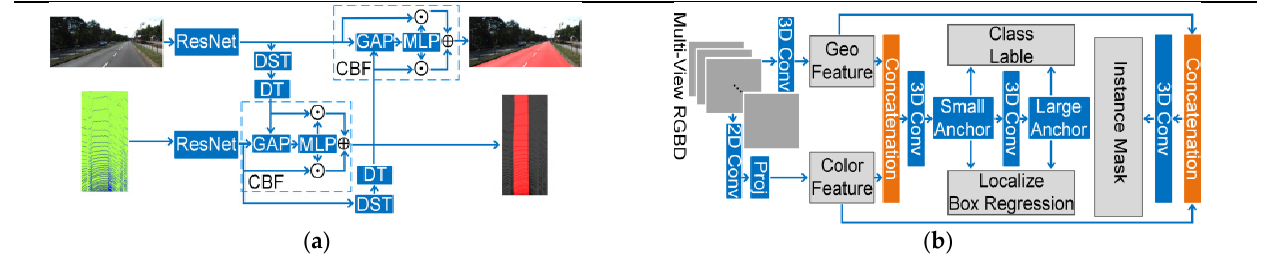
Figure 4. The representative segmentation methods using multi-stage feature-based fusion strategy. ( a ) BiFNet; ( b ) 3D-SIS.